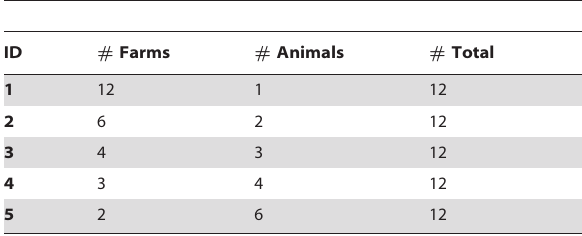
Table 1. List of sampling strategies evaluated by